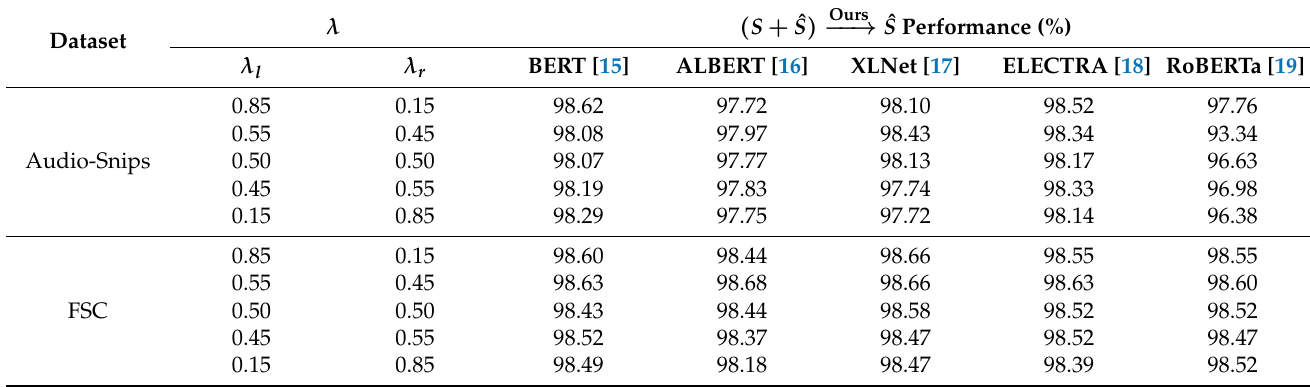
Table 7. Performance comparison of intent classification according to the different values of hyperpa- rameters in two